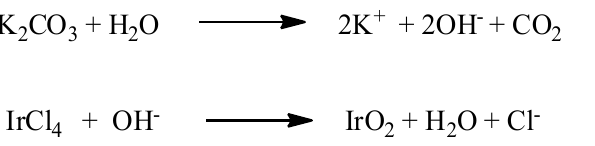
Figure 9. TEM image of IrO 2 nanorods obtained through the molten salt method (Re- printed/adapted with permission from Ref. [106]). Interestingly, within the molten salt method, by carefully varying the IrCl 4 : NaCl: KCl ratio, it is possible to tune the morphology of the IrO 2 nanostructures [108]. In partic- ular, it has been reported that, using a IrCl 4 : NaCl: KCl ratio of 1: 10: 10, nanocubes are obtained (Figure 10a); while changing the IrCl 4 : NaCl: KCl ratio to 1: 30: 30, a mixture of IrO 2 nanocubes and nanorods is formed (Figure 10b); and ultimately, using a high salts percentage, specifically using a 1: 60: 60 ratio, a sample consisting predominantly of na- norods is obtained (Figure 10c). This experimental observation was explained by Mao et